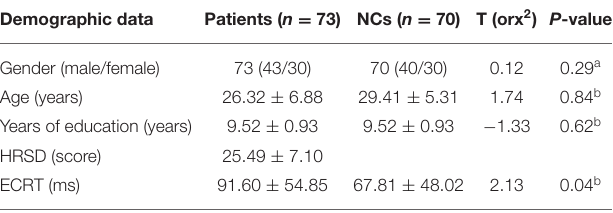
TABLE 1 | Characteristics of the